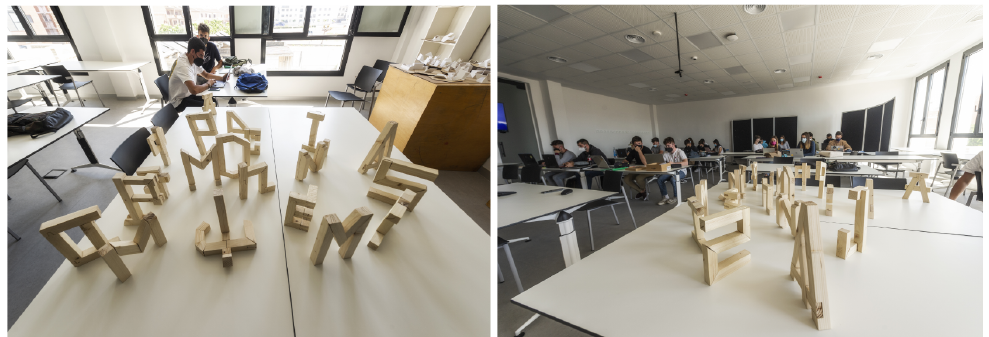
Figure 5. The letters challenge. Letters made by students.